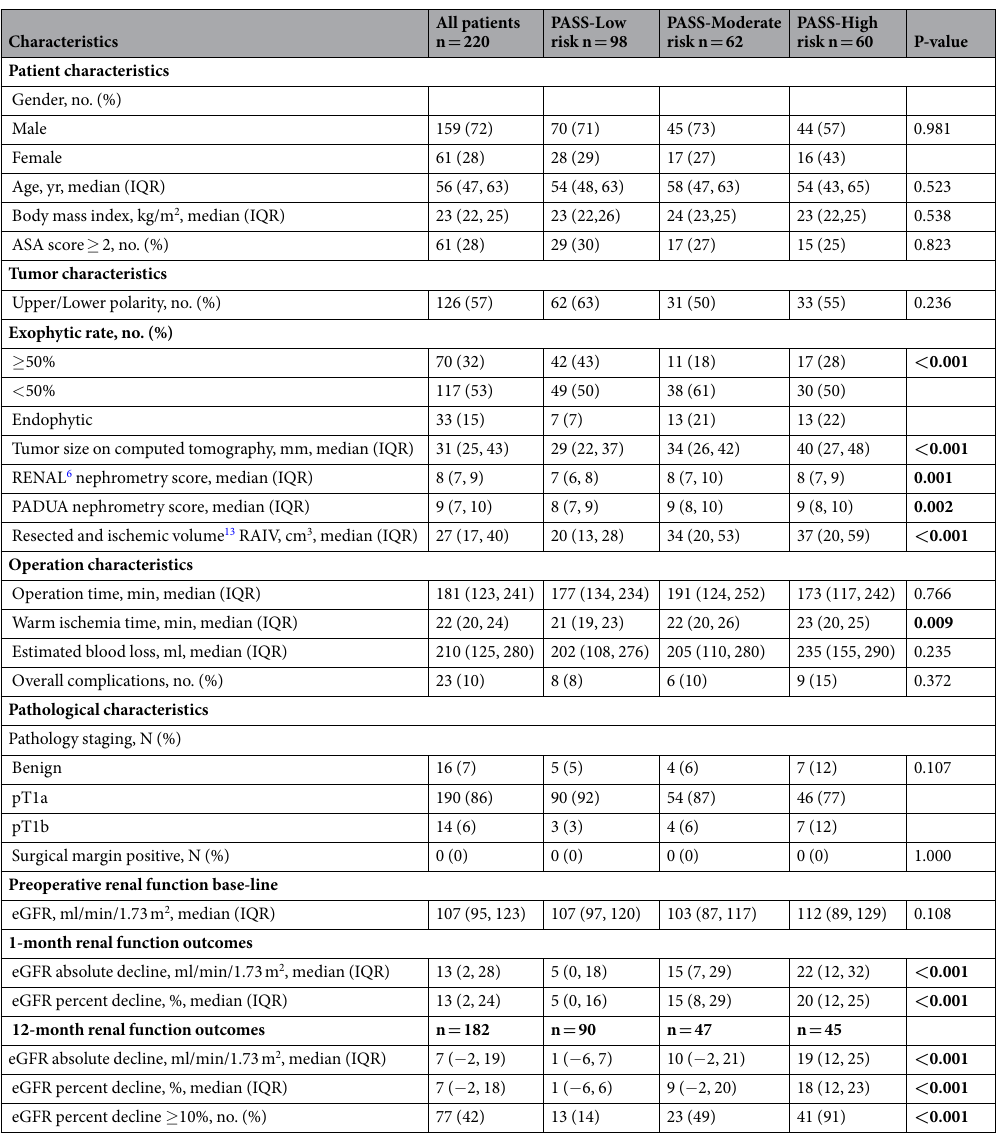
Table 1. Clinical variables and renal function outcomes of discovery cohort. PASS = Peritumoral